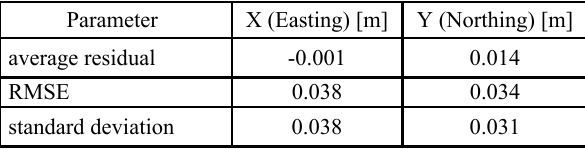
Table 1. Accuracy characteristics of